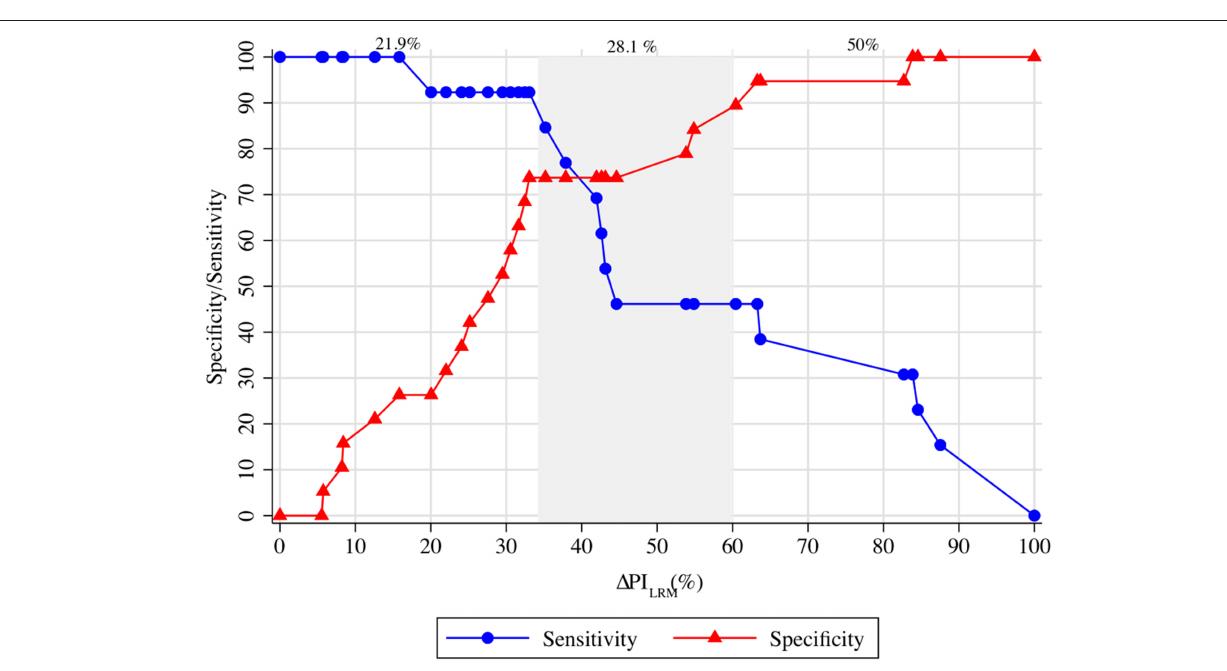
FIGURE 4 | The gray zone approach of 1 PI LRM and 1 SV VE . 1 PI LRM < 35.0% represents fluid non-responsiveness with a sensitivity > 90%. Moreover, 1 PI LRM > 60.0% represents fluid responsiveness with a specificity > 90%. The inconclusive zone of 1 PI LRM is spread between 35.0 and 60.0%, which represents 28.1% of the population. LRM, lung recruitment maneuver; SV, stroke volume; PI, perfusion